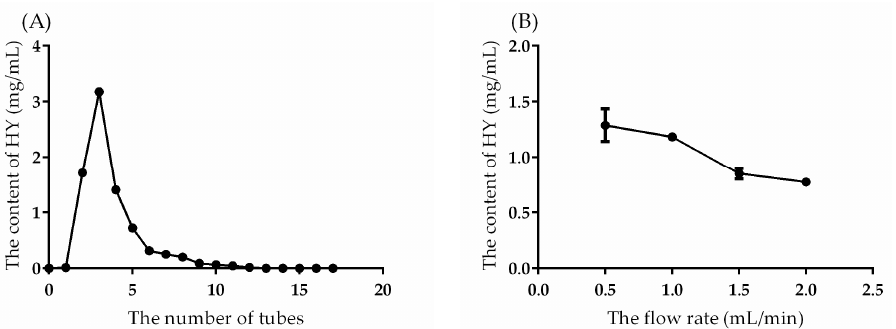
Figure 5. ( A ) The elution rate and ( B ) the effect of flow rate on the content of HT. Note: number of tubes meant the elution solution was collected in a 5 mL tube and the content of HY in each tube was